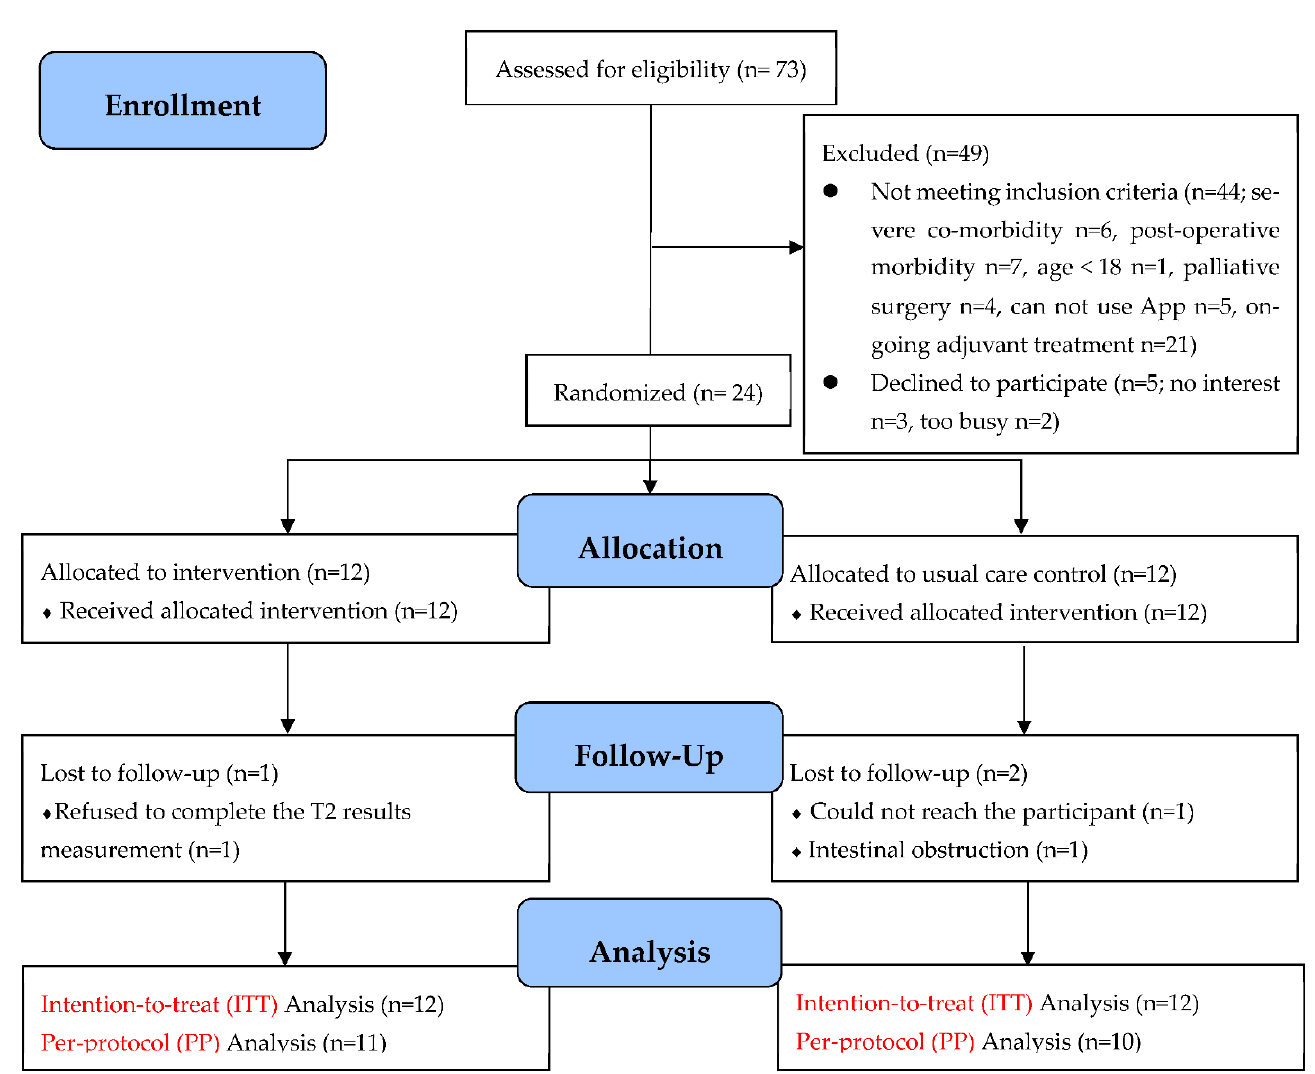
Figure 3. Enrollment, randomisation, and follow-up profile (CONSORT flow diagram).